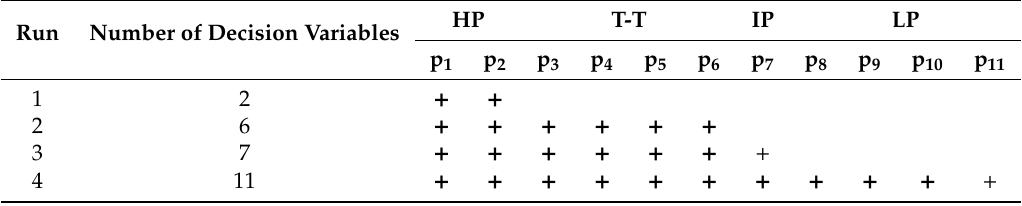
Table 6. The groups of decision variables investigated in each run.